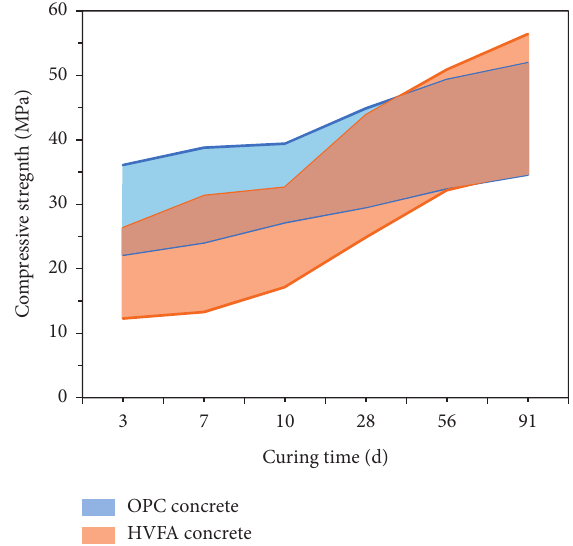
Figure 5: Temporal evolution of compressive strength of OPC and HVFA concretes, based on the data collected from reference